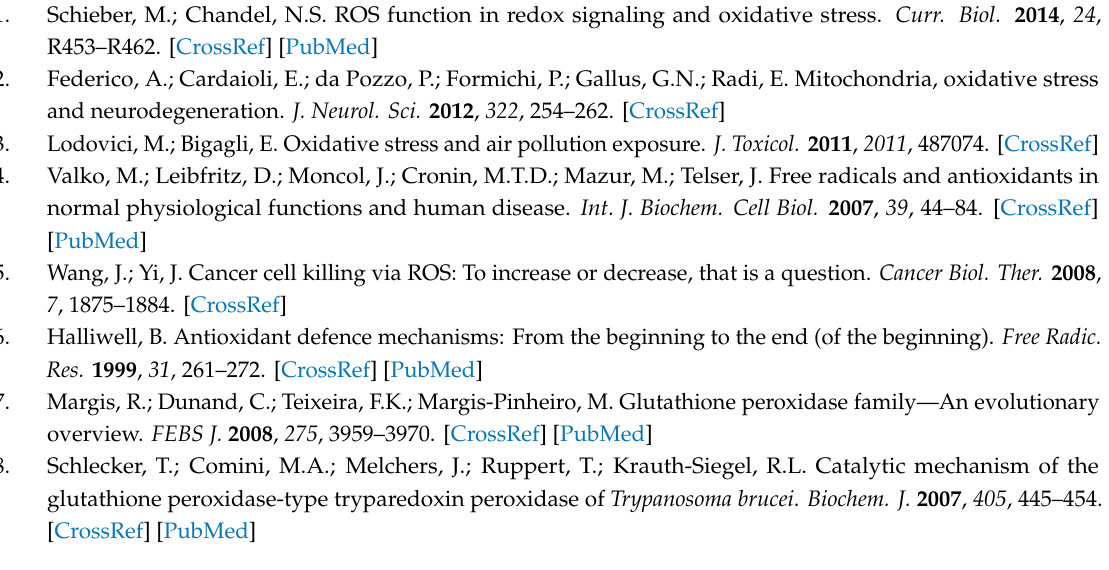
Figure S1: Phylogenetic relationships among GPxs of various organisms, reconstructed on the basis of amino acid sequences and using both BI and ML methods; Figure S2: Detection of selective pressure on GPx using mechanistic empirical combination (MEC); Figure S3: Coding and deduced amino acid sequences of tt-gpx3 ; Figure S4: Coding and deduced amino acid sequences of tt-gpx7 ; Figure S5: Coding and deduced amino acid sequences of tt-gpx8 ; Figure S6: Coding and deduced amino acid sequences of tt-gpx11 ; Table S1: Gene sequences of GPx (and their accession numbers) used for phylogenetic reconstruction; Table S2: Sequences of primers used for PCR amplification of T. thermophila GPx